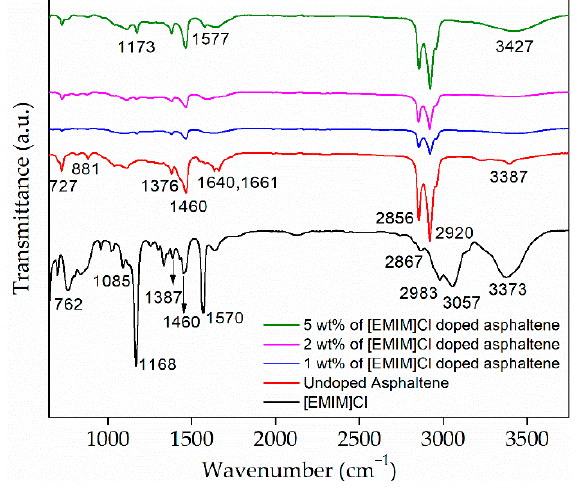
Figure 3. Fourier Transform Infrared spectroscopy of the undoped and [EMIM]Cl-doped asphaltene thin films. Table 3. Peak descriptions of the ATR-FTIR for the undoped and [EMIM]Cl-doped asphaltene.